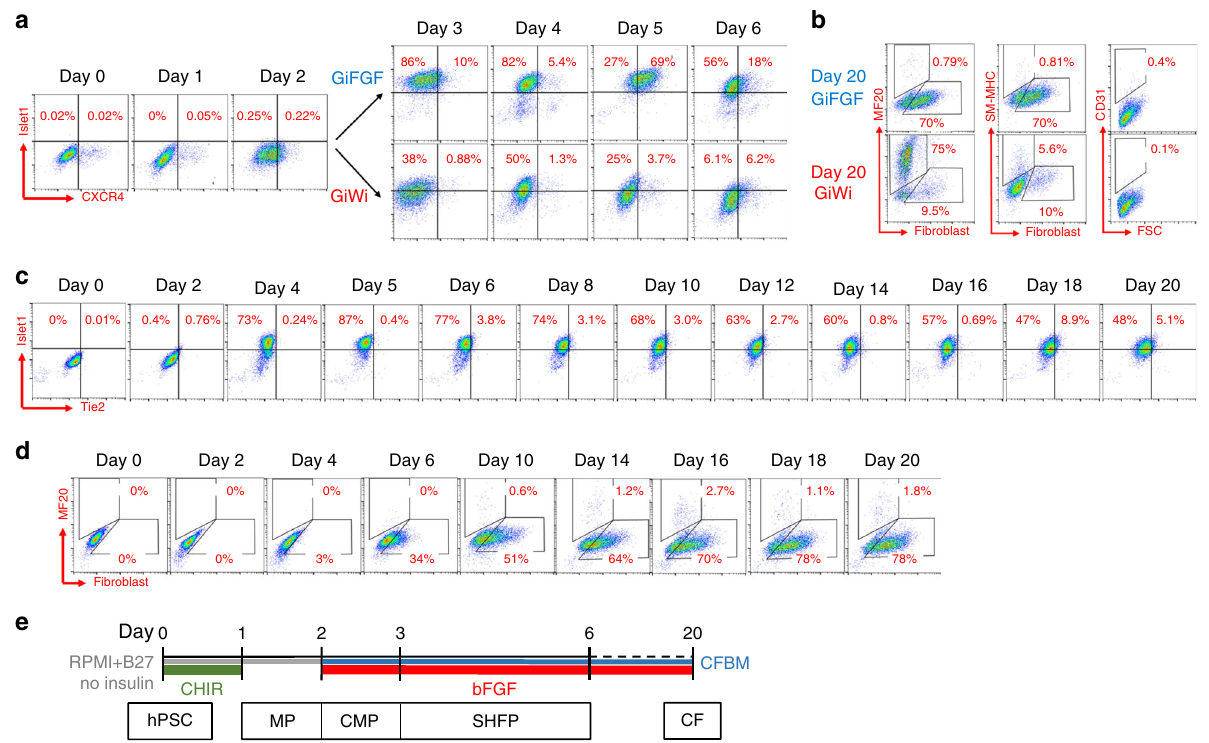
Fig. 4 Evaluation of progenitors and cardiovascular lineages in CF and CM differentiation. a Flow cytometry analysis of cells on day 0 – 6 in the GiFGF and GiWi protocols for FHF/SHF marker Islet1 and SHF marker CXCR4. For day 0 – 2, the protocols are identical, diverging on day 3. b Flow cytometry analysis of the day 20 differentiated cells from the GiFGF and GiWi protocols for fi broblasts (anti-human fi broblasts, clone TE-7), CMs (MF20), smooth muscle cells (SM-MHC), and endothelial cells (CD31). c Flow cytometry analysis of cells throughout the GiFGF protocol for expression of Islet1 and the endothelial progenitor marker, Tie2. d Flow cytometry analysis of cells throughout the GiFGF protocol for expression of the fi broblast marker (anti-human fi broblasts, clone TE-7). e Schematic method of the GiFGF protocol and stage-speci fi c progenitors in differentiation of hPSCs to CFs. Gray lines indicate RPMI medium + B27 without insulin supplement; blue lines indicate cardiac fi broblast basal medium (CFBM); green lines indicate CHIR treatment; red lines indicate bFGF treatment. MP mesodermal progenitor, CMP cardiac mesodermal progenitor, SHFP second heart fi eld progenitor, CF cardiac fi broblast. The data are